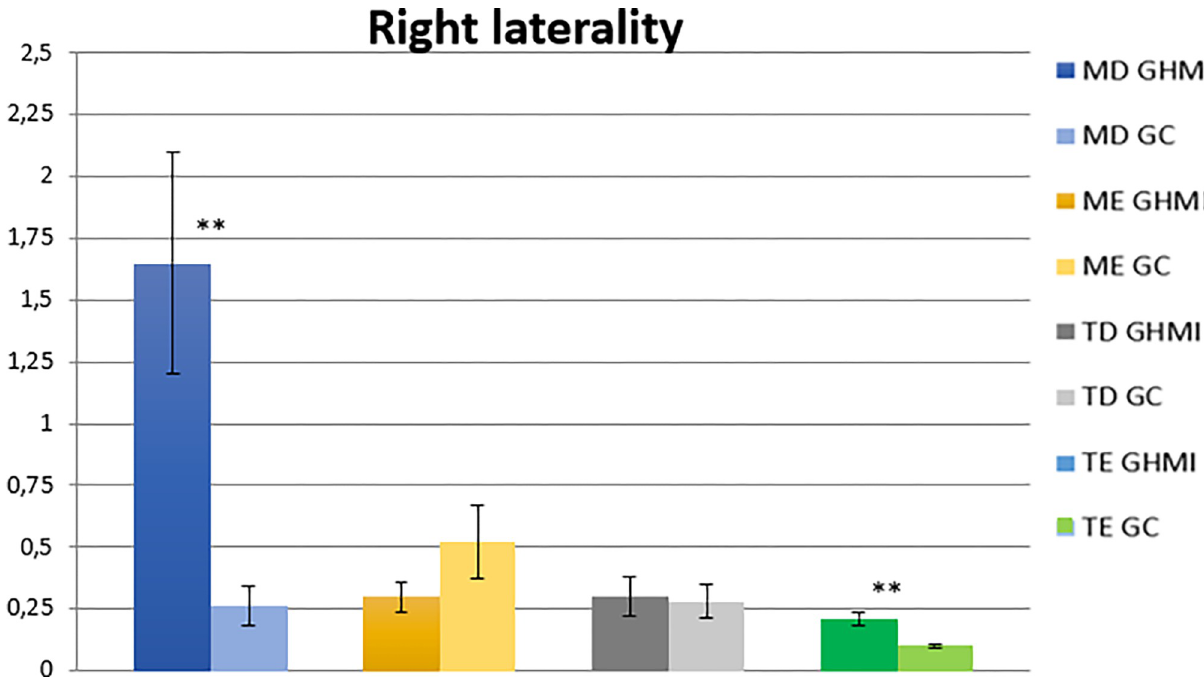
EMG, electromyographic; MIH, Molar-incisor hypomineralization; CG, control group; MIHG, MIH group. Significance < 0.05 = � ; Significance < 0.01 = �� ;